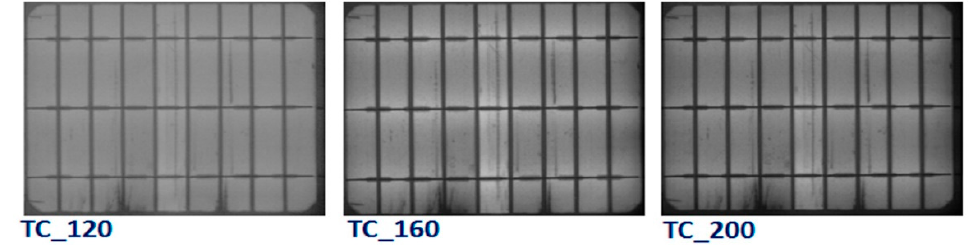
Figure 14. EL images of PV modules without concrete after various thermal cycling tests (0, 40, 80, 120, 160, and 200 cycles) [67].